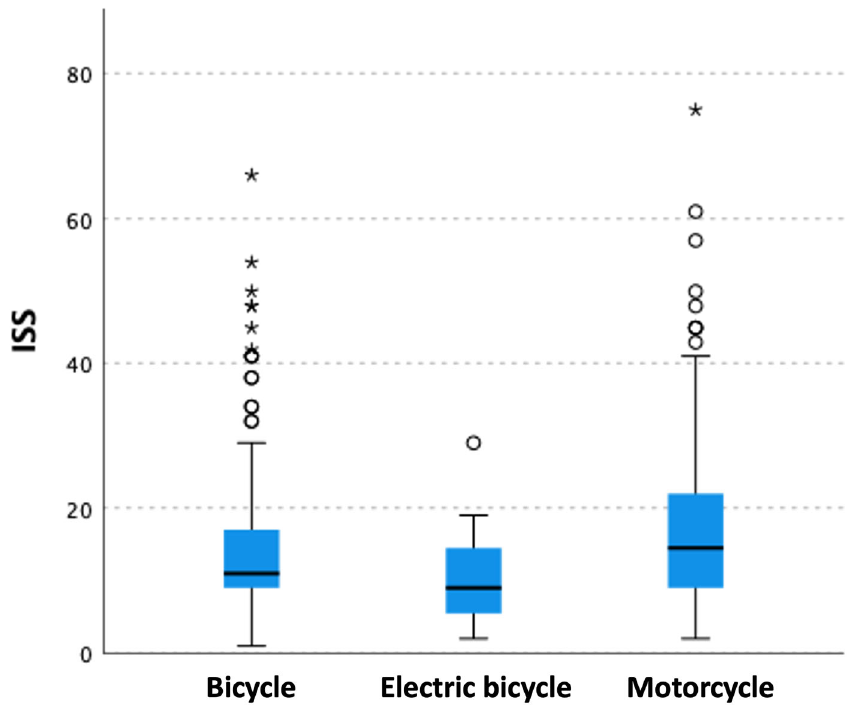
Figure 3. Mean Injury Severity Score (ISS) of patients stratified by vehicle. The boxplot shows mean and median ISS of patients stratified by their used vehicle. Circle = Outlier; Asterisks = Extreme Outlier.